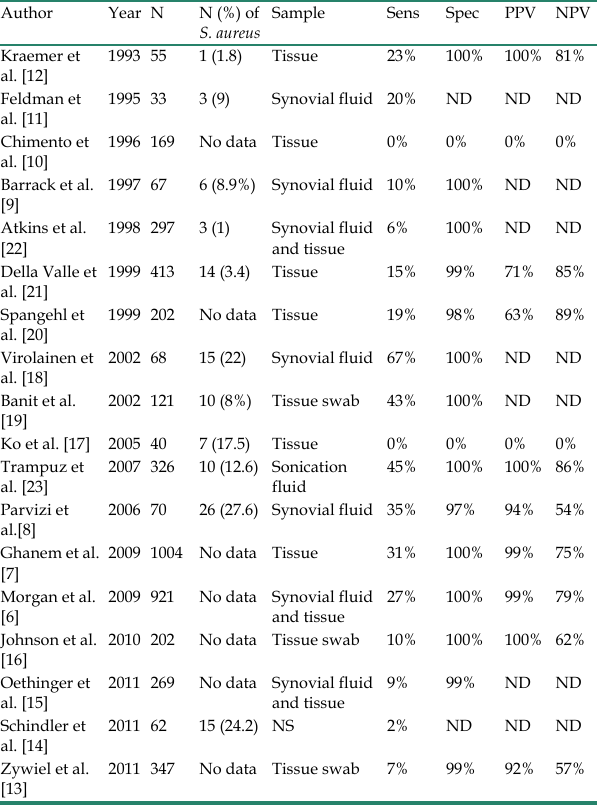
Table 1 . Studies performed on Gram staining in revision surgery. This Table was partially duplicated from the meta-analysis performed by Ouyang et al.